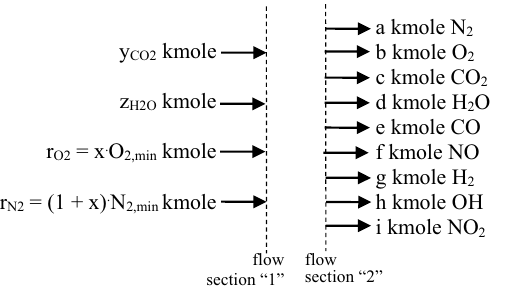
Figure 12. The inlet/outlet flow scheme of chemical species for